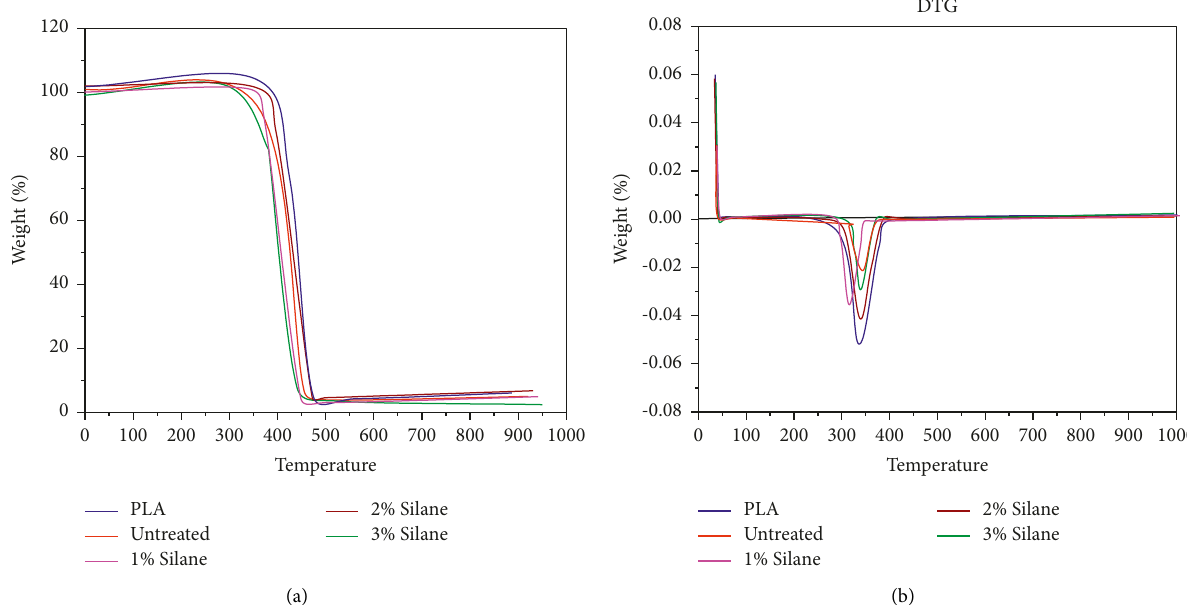
Figure 4: (a) Thermogravimetric analysis (TGA) and (b) difference thermogravimetry (DTG) results of